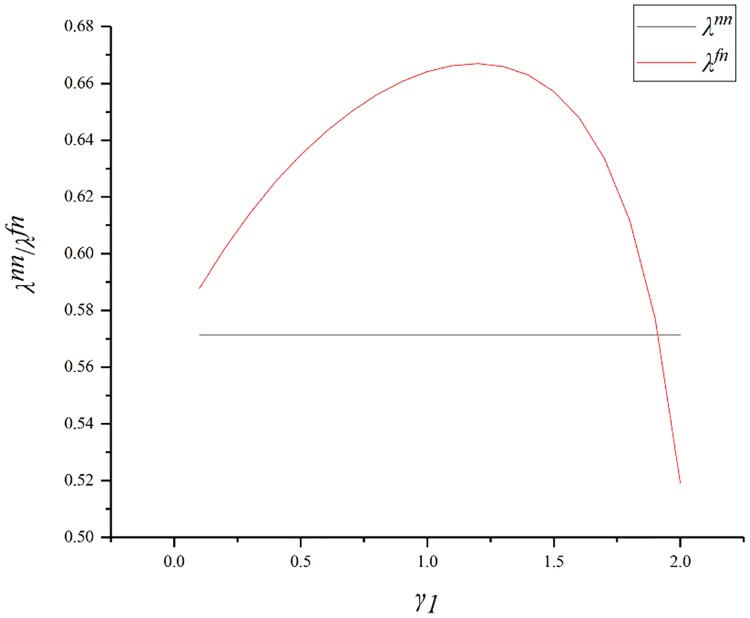
Impact of γ1 on λ.